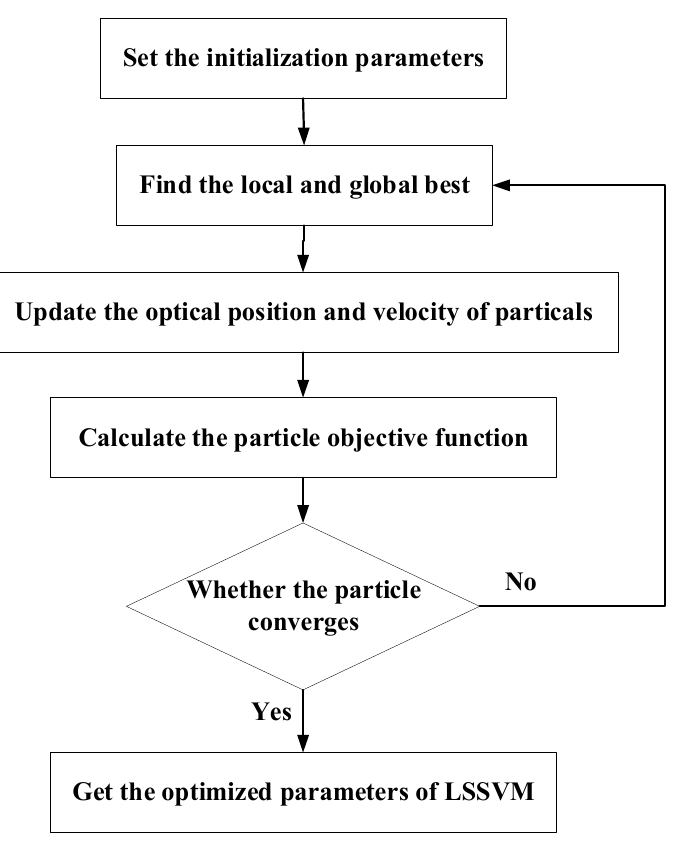
Figure 2. Flowchart of PSO ‐ LSSVM.